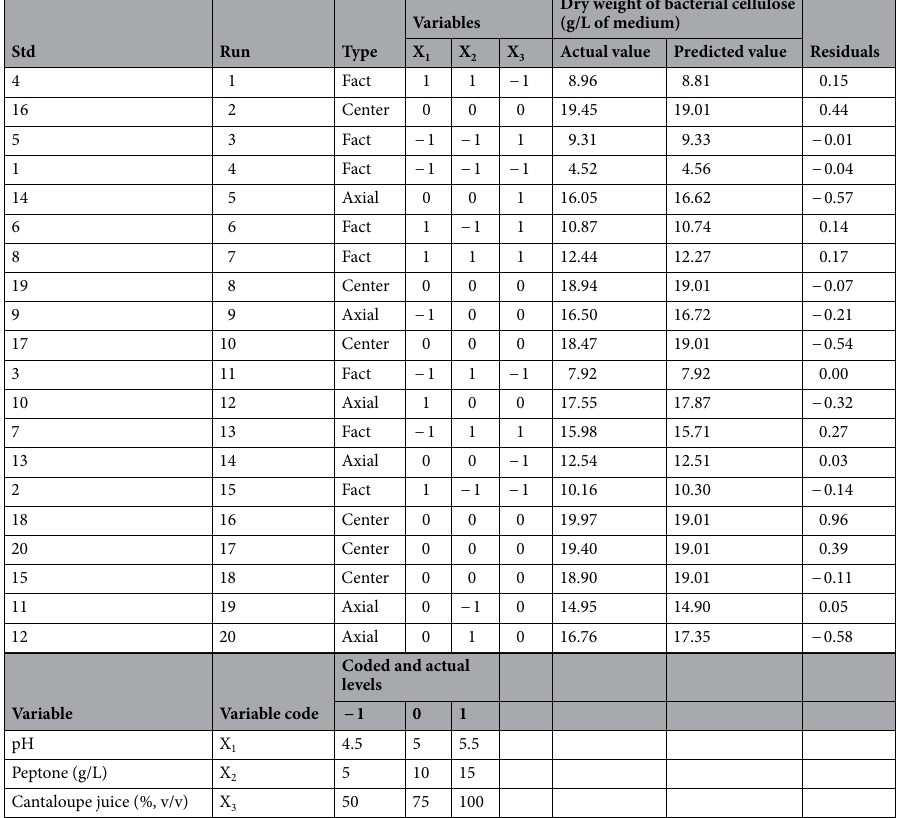
Table 4. Face centered central composite design for evaluation of independent factors with coded values along with the experimental bacterial nanocellulose by Bacillus sp . strain SEE-3.